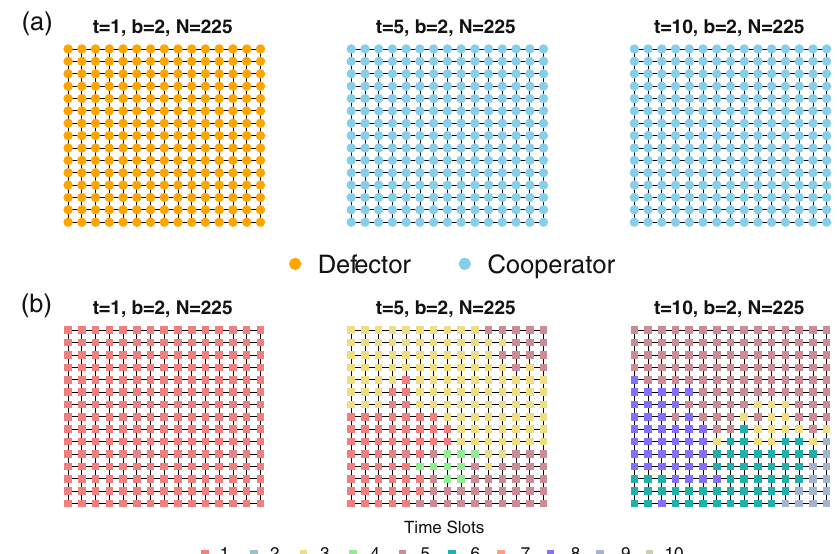
Fig. 1 Evolution of behavioral strategies and time of implementation in an example run. The fi gure displays the fi nal distribution of behavioral strategies ( a ) and time slots in which behavior is implemented ( b ) in an example run of the simulation. The lattices in each column result from data generated in the same simulation run, with parameters set at those listed above each grid. Selection favors defectors when t = 1 ( a , leftmost panel) with all agents pooled into the same time slot at G = 10000 ( b , leftmost panel). When t = 5, cooperators come to dominate the population ( a , middle panel) and selection leads to behavioral implementation at 4 time slots ( b , middle panel). When t = 10: fi xation of cooperators occurs ( a , rightmost panel) and the population evolves to implement that strategy at 5 different time slots ( b , rightmost panel).